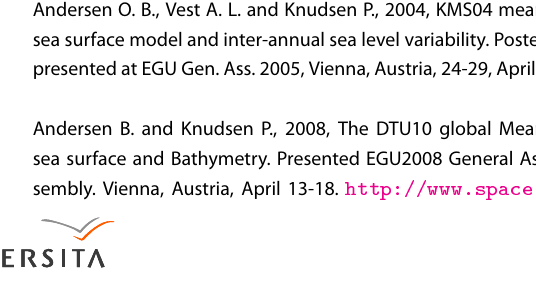
models derived from calibrated and combined satellite al- timetry observations, etc.). For this, JWG 0.1.1 will take into ponents in the respective (cid:246)eld of speciality (Fig. 8). This analysis shall also include an investigation about the time- dependence of W 0 .